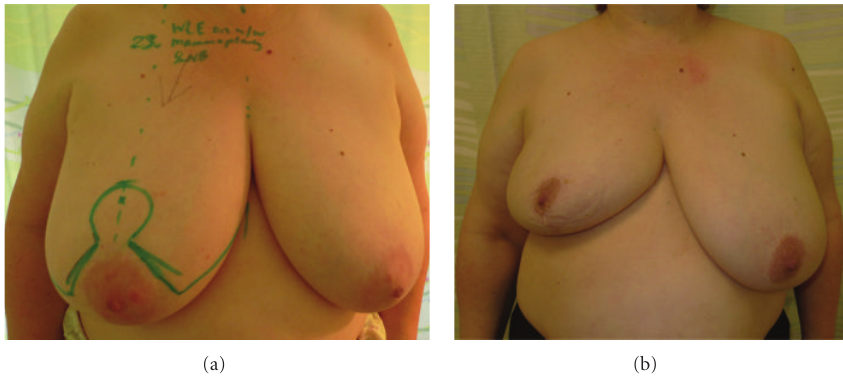
Figure 3: (a) This 63-year-old patient with large ptotic breasts presented with a tumour in the right breast. The skin markings show the planned incisions for a therapeutic inverted-T mammoplasty. (b) Postoperative images of the same patient after completion of adjuvant chemotherapy and prior to commencing radiotherapy. The inverted-T mammoplasty gives a satisfactory result and is in proportion to the patient’s body habitus. Reduction mammoplasty of the contralateral breast, to improve symmetry, is planned to be performed six months after completion of adjuvant radiotherapy.